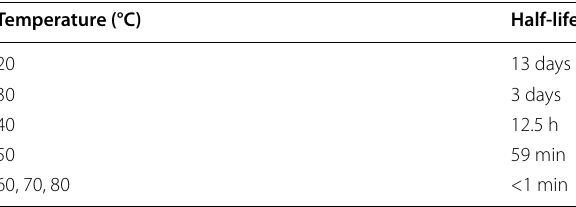
Table 3 Half-life of 500 µg ml − 1 Mrl2 after incubation in 50 mM potassium phosphate buffer, pH 7 at different